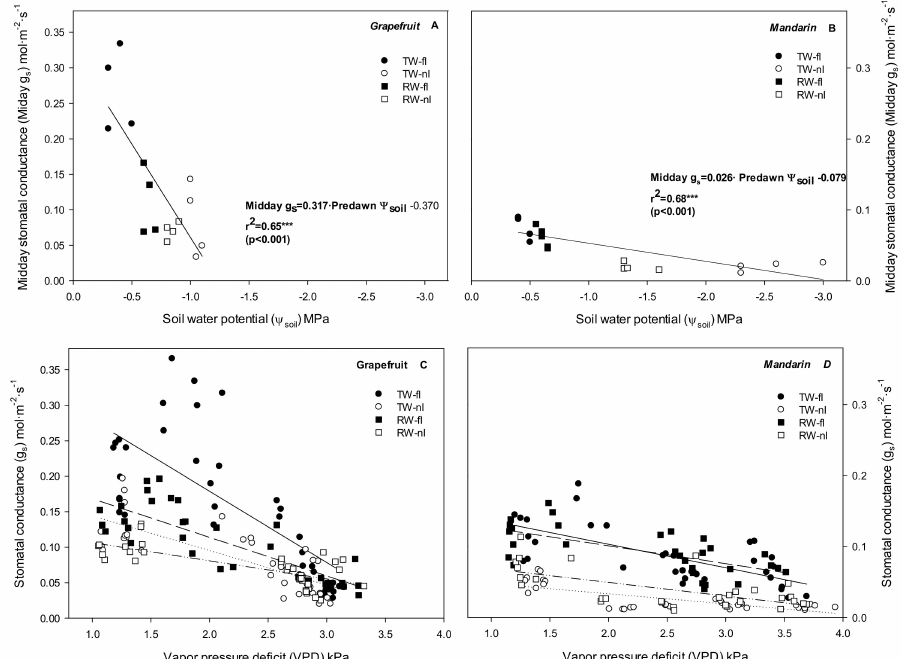
Figure 4. Correlations between midday stomatal conductance (Midday g s ) and soil water potential ( Ψ soil ) values ( A , B ) and between stomatal conductance (g s ) and vapor pressure deficit (VPD) values ( C , D ) for each treatment (TW-fI: transfer water—fully irrigated; TW-nI: transfer water—non-irrigated; RW-fI: reclaimed water—fully irrigated; RW-nI: reclaimed water—non-irrigated) and crop (grapefruit and mandarin). Each point is the average of the two central trees of each block. The regression lines between g s and VPD for grapefruit plants were ( C ): TW-fI: g s = − 0.100 · VPD + 0.170; r 2 = 0.53 *** ( p < 0.001); TW-nI: g s = − 0.049 · VPD + 0.223; r 2 = 0.61 *** ( p < 0.001); RW-fI: g s = − 0.054 · VPD + 0.193; r 2 = 0.69 *** ( p < 0.001); RW-nI: g s = − 0.026 · VPD + 0.132; r 2 = 0.52 *** ( p < 0.001). The regression lines between g s and VPD for mandarin plants were ( D ): TW-fI: g s = − 0.033 · VPD + 0.170; r 2 = 0.48 *** ( p < 0.001); TW-nI: g s = − 0.014 · VPD + 0.062; r 2 = 0.55 *** ( p < 0.001); RW-fI: g s = − 0.025 · VPD + 0.152; r 2 = 0.42 *** ( p < 0.001); RW-nI: g s = − 0.019 · VPD + 0.088; r 2 = 0.39 *** ( p <